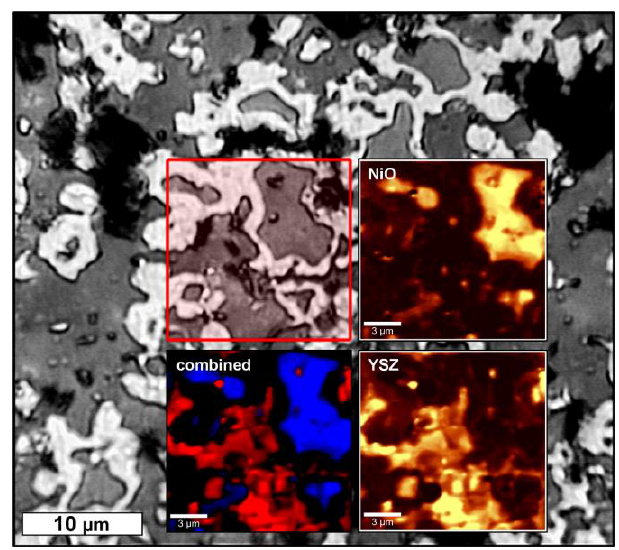
Figure 6. Confocal Raman-microscopic analysis of a crossection–microsection of the Z50N50-1400r sample. The greyscale image is an optical micrograph and the red-framed area was analyzed by Raman spectroscopy. The distribution of the NiO and YSZ phases in the scanned area is shown as inset. The Ni phase is represented as black areas in the color-coded combination of the NiO (blue) and YSZ (red) distribution.